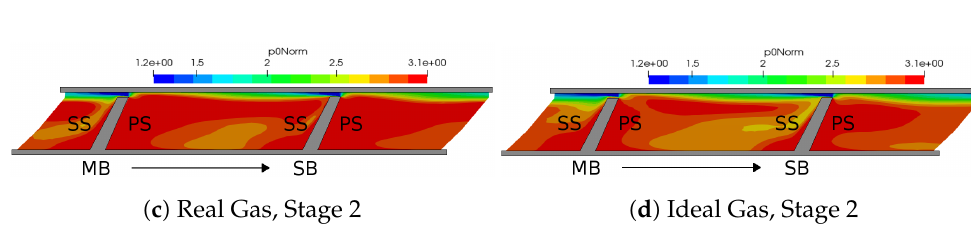
Figure 13. Normalized Total Pressure Isolines, IP1